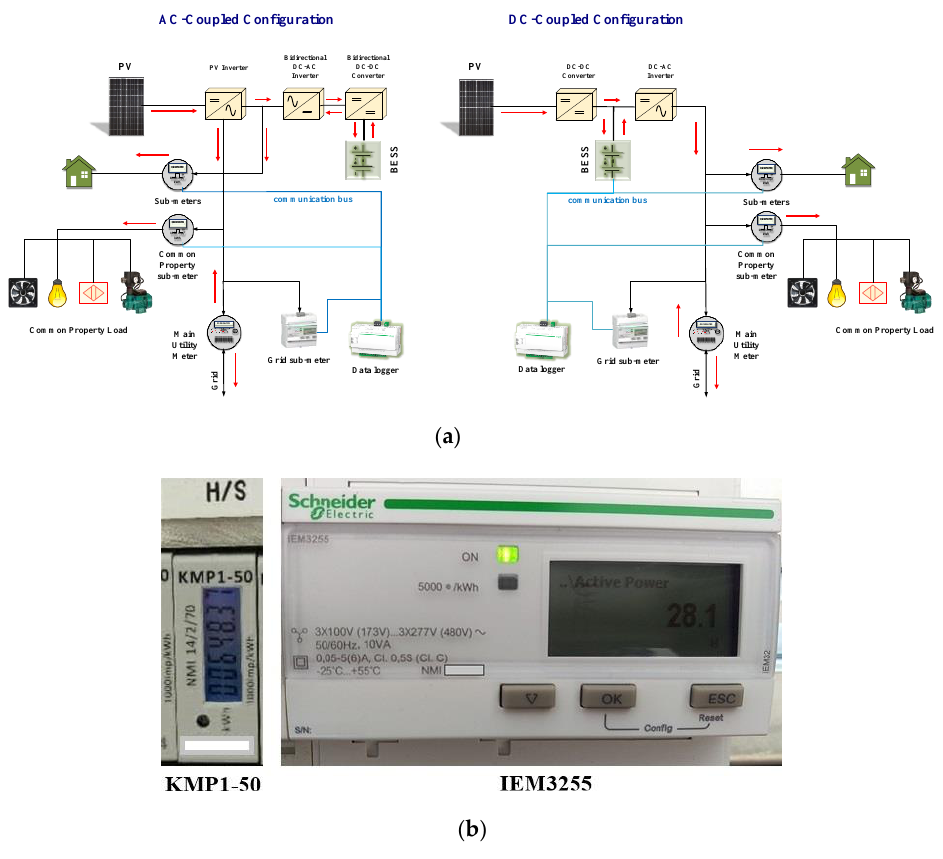
Figure 2. ( a ) Common property (CP) load connection to AC- and DC-coupled configurations. ( b ) Pulse meters used for measuring CP